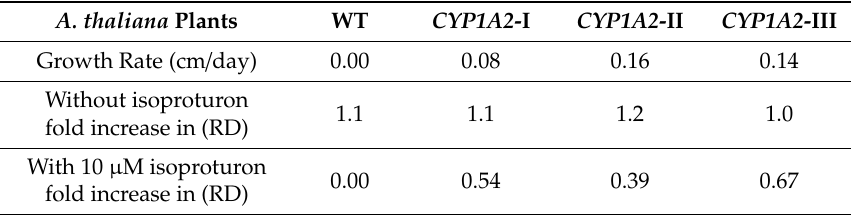
Table 2. Isoproturon e ff ect on the growth rate of A. thaliana wild type compared to di ff erent transgenic lines ( n =